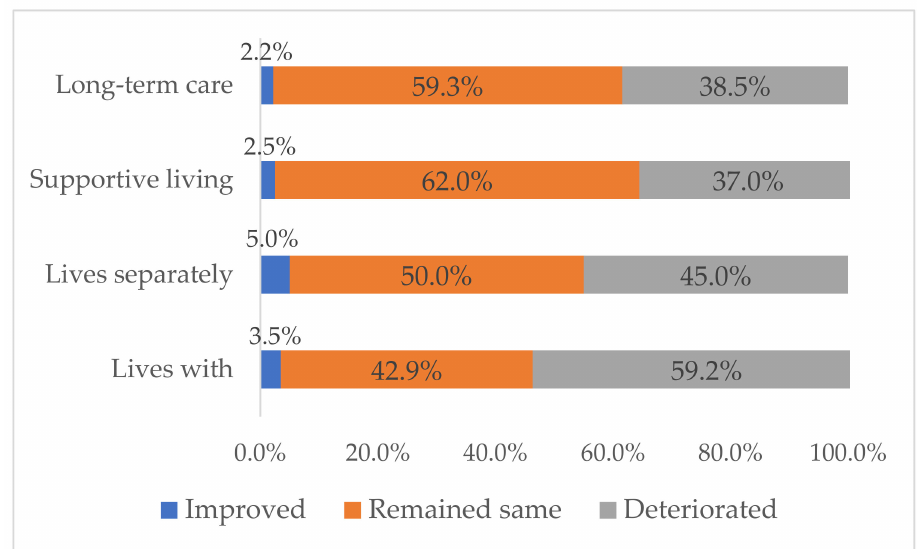
Figure 3. Caregiver’s Self-rated Changes in Physical